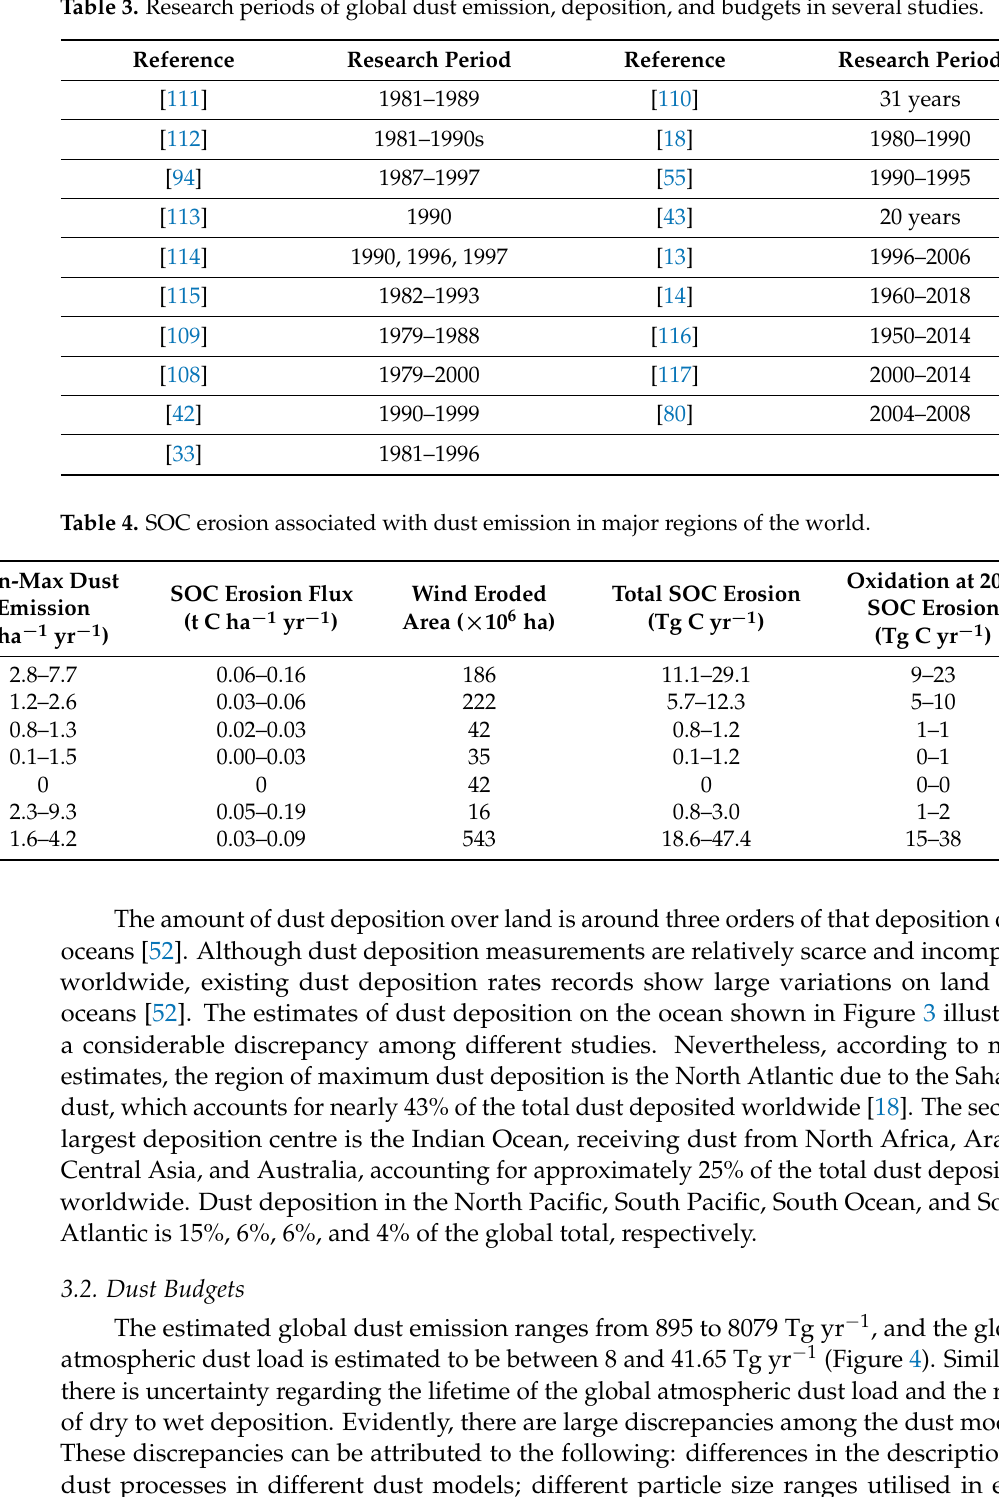
Table 3. Research periods of global dust emission, deposition, and budgets in several studies.